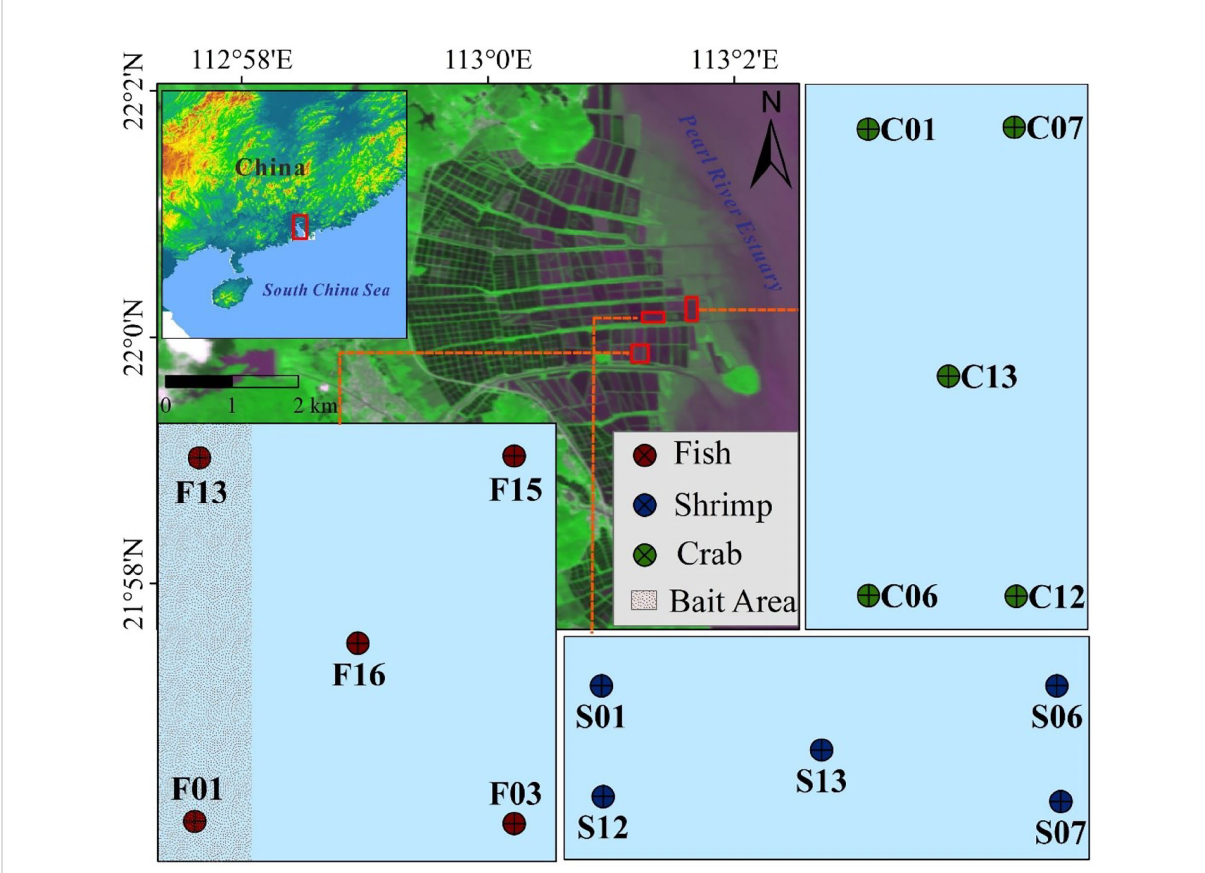
FIGURE 1 Study area and sampling sites of three types of reclaimed aquaculture ecosystem in the Pearl River